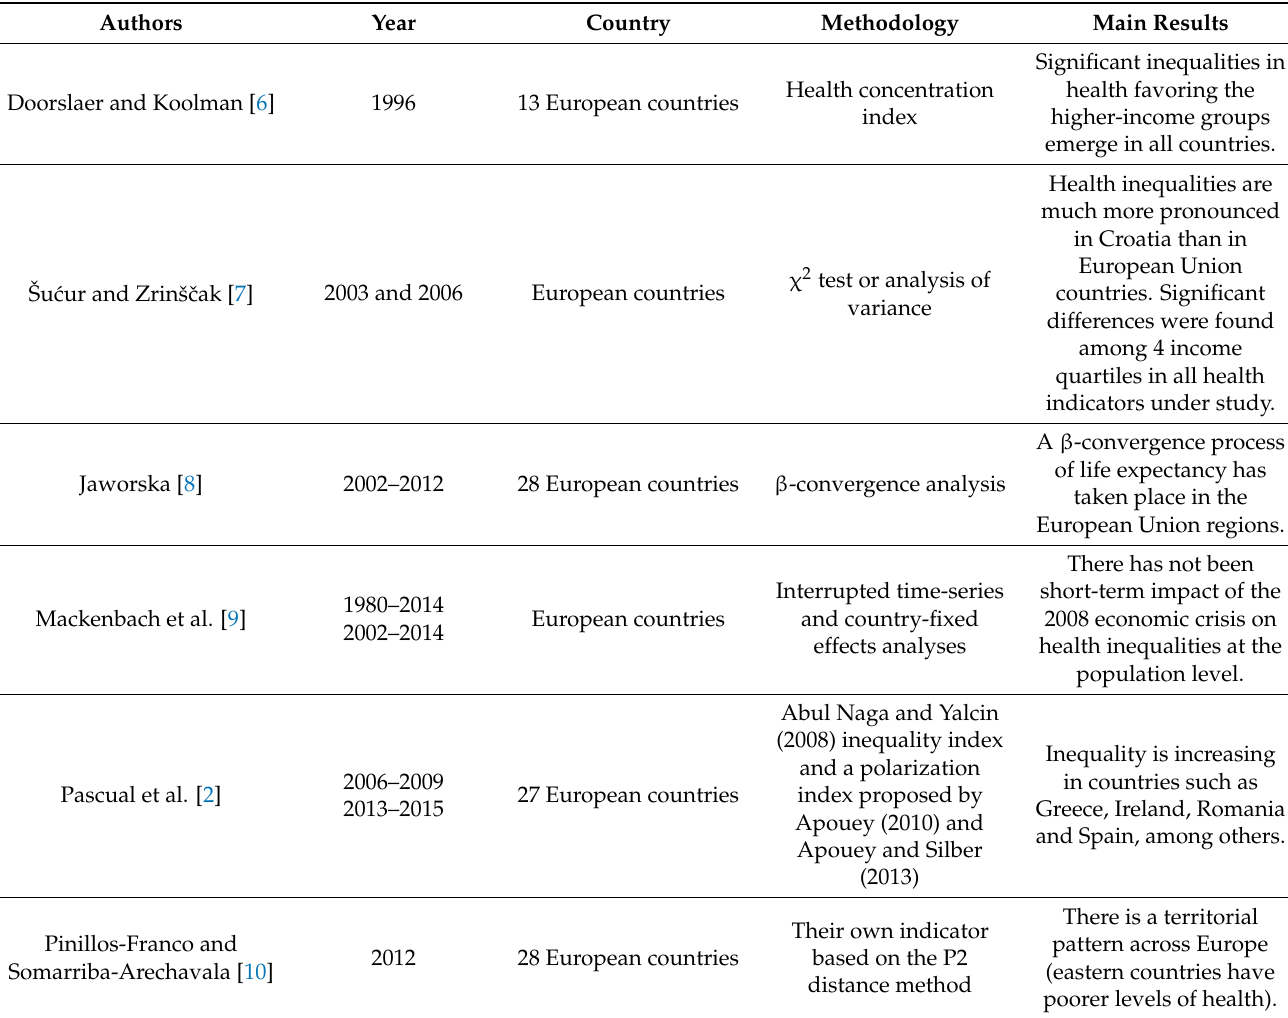
Table 1. Main conclusions of the studies about health inequality